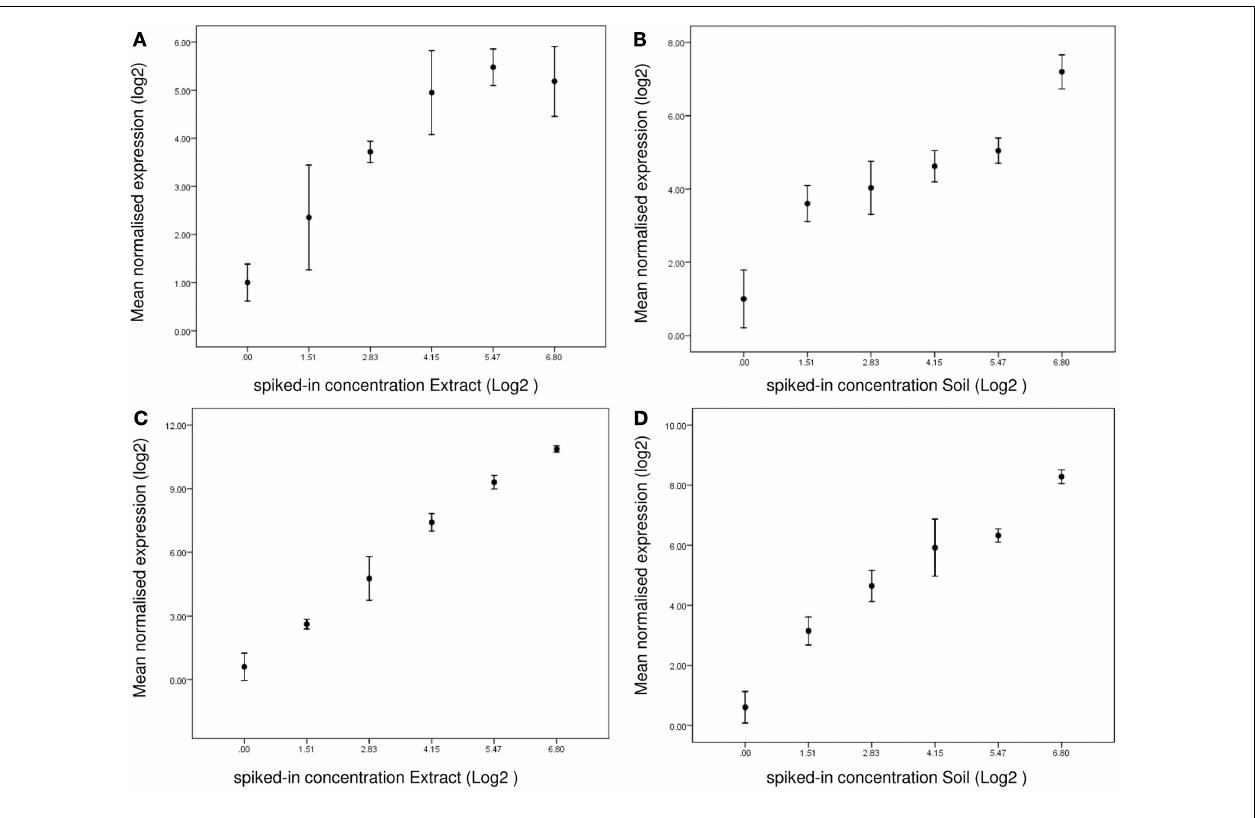
response to Extracts. (D) CYP6N3v2 expression in response to Soils. X-axis, Log2 transformed spiked-in concentrations.Y-axis, Log2 normalized gene